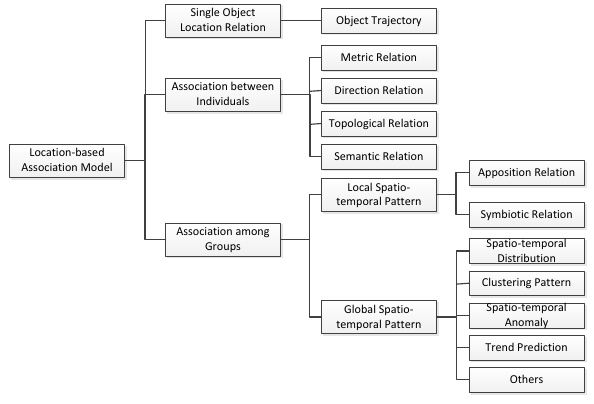
Figure 4. Location-based Association Model